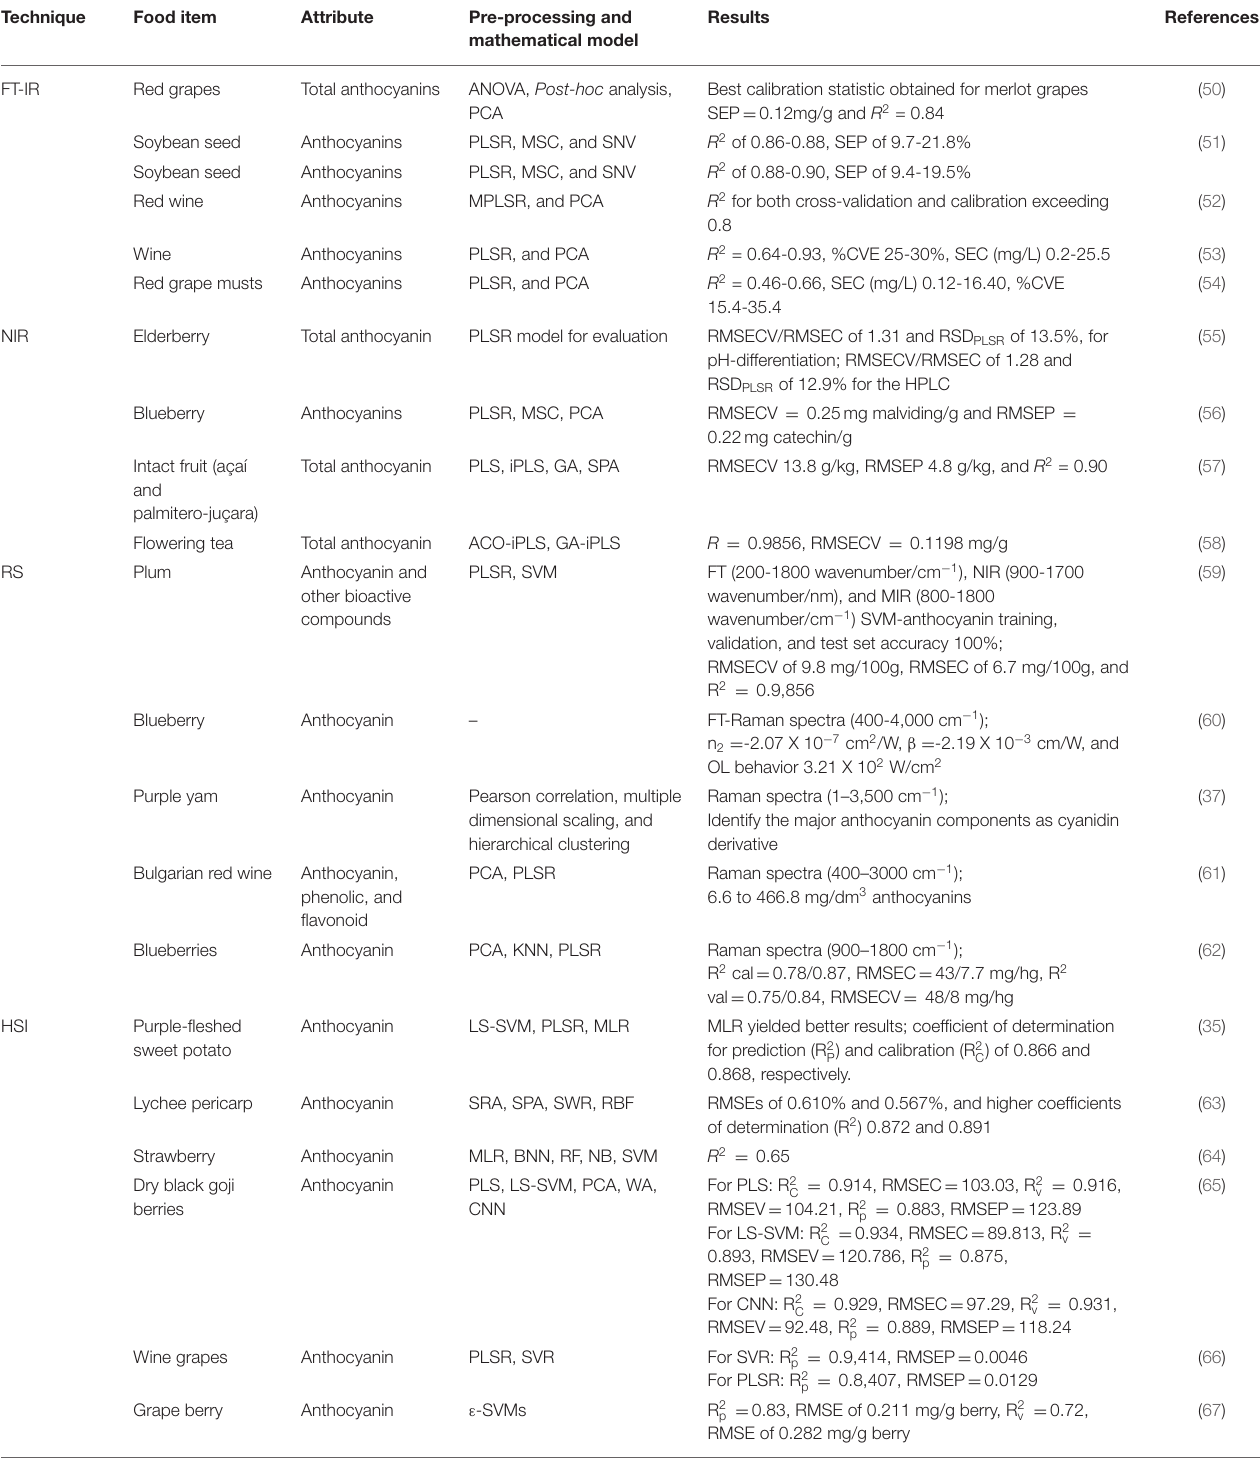
TABLE 1 | FTIR, NIR, HIS, and RS techniques for the measurement of anthocyanin.